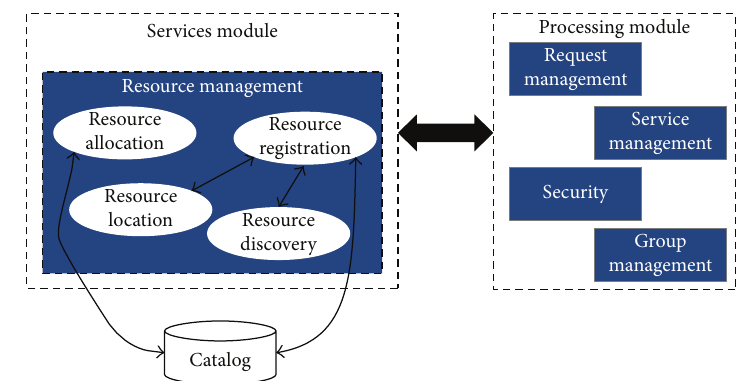
Figure 2: Architecture of the secure middleware.